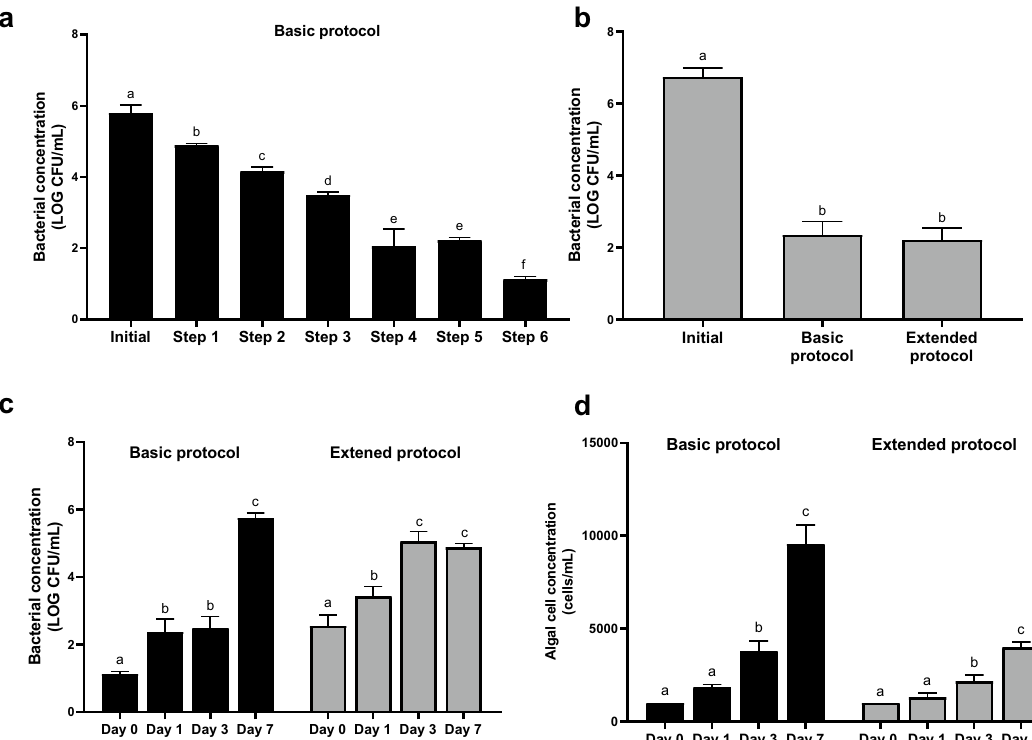
Figure 3. Bacterial removal in the KMHK sample using the basic and extended protocols. ( a ) Total bacterial count after different steps in the basic protocol. Initial: the initial bacterial count in KMHK samples at the beginning; Supplementary Fig. 1 illustrate the Step 1 to 6 of basic protocol. ( b ) Total bacterial count after the basic and extended protocols. Extended protocol refers to the descriptions in material and method. ( c ) Total bacterial count in the treated KMHK cultures at different days of cultivation. ( d ) Algal cell concentration during the regrowth of the treated KMHK cultures. All data are presented as mean ± standard deviations of three independent experiments (n = 3). Different letters on the top of the bar indicate that means were significantly different among samples at p ≤ 0.05 according to one-way analysis of variance followed by Tukey multiple comparison